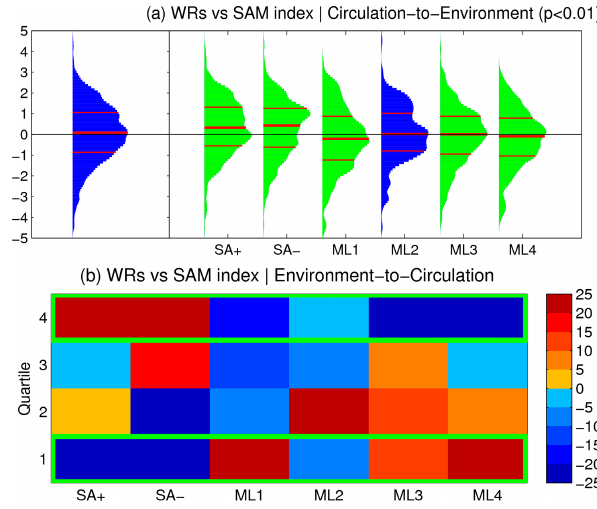
Figure 8. (a) Circulation-to-environment characterisation (C2E): (left panel) daily Southern Annular Mode (SAM) index distribution and (right panel) for each ERA5 WR. Probability density functions are estimated by using a normal kernel density; red lines represent 25th, 50th and 75th percentiles. Anomaly distributions significantly different from the climatological sample are displayed in green (sig- nificance is assessed by a Kolmogorov–Smirnov test at the 95% level of confidence). The p value of the ANOVA used to assess the C2E characterisation is reported in brackets. (b) Environment-to- circulation characterisation (E2C): ERA5 WR frequency anomaly for each quartile of the daily SAM index. Values represent per- centage changes relative to climatological frequencies. Green boxes highlight significant changes in the WR frequencies, i.e. frequency anomalies exceeding the critical threshold (11.07) for the chi-square statistics with 5 degrees of freedom at the 95% level of confidence (see Sect. 2.4 for